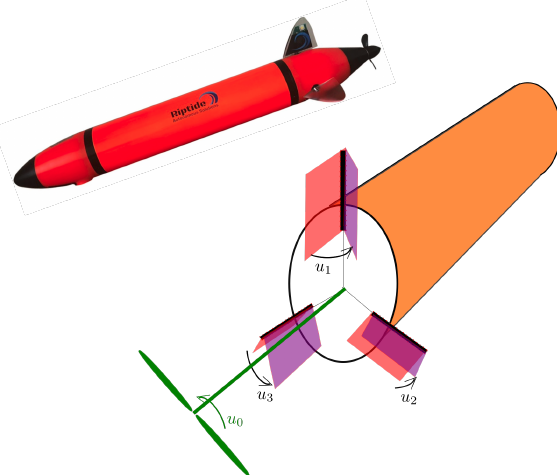
Figure 2. The Riptide robot has one propeller and three